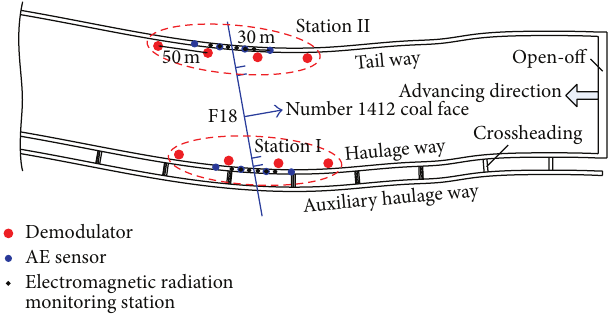
Figure 6: Number 1412 coal face and station